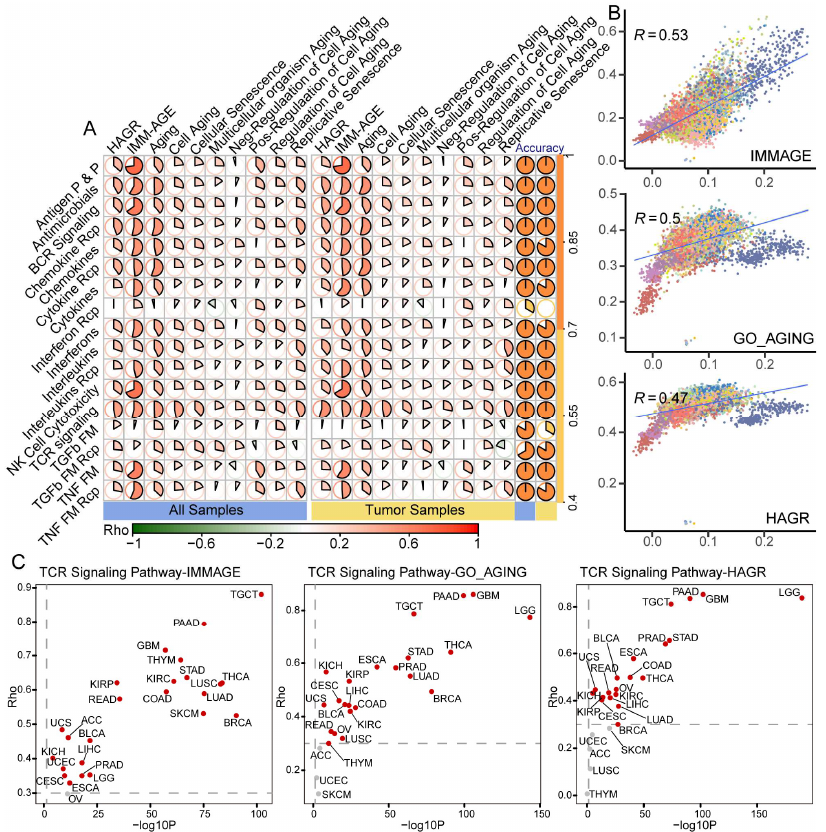
Figure 3. Evaluation of the age-related value of IRPs using benchmark gene sets. ( A ) Correlation pie plots between 17 IRPs and 10 ARGs in all/tumor samples. Right pie plots showing the validation results by mutual information analysis. ( B ) Correlation curves of TCR signaling pathways and 3 ARGs in all samples. Colors denote different primary tissue origins. ( C ) Volcano plots showing the correlations between TCR signaling pathways and 3 ARGs at cancer-specific level.